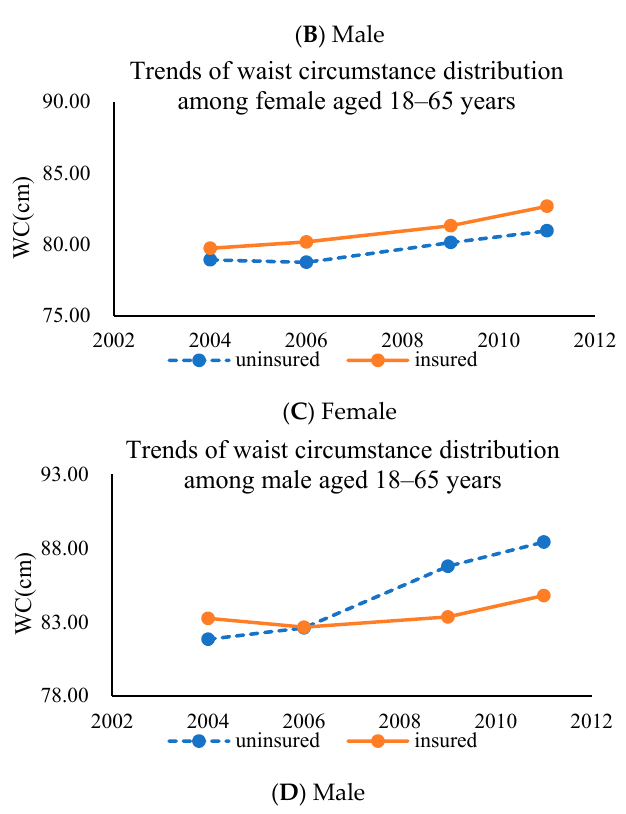
Figure 2. Shift in distribution of Body Mass Index (BMI) and Waist Circumstance (WC) in Chinese rural residents (( A ) BMI of Female, ( B ) BMI of Male, ( C ) WC of Female, ( D ) WC of Male) by insurance status from 1991 to 2011.